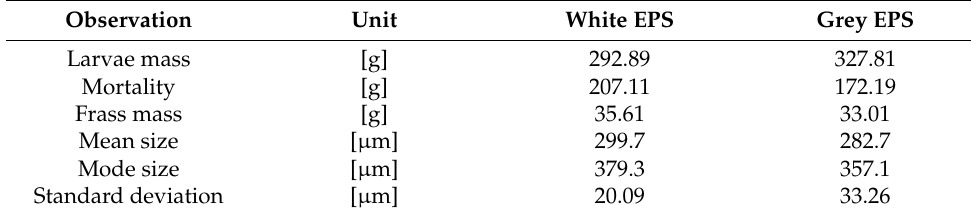
Table 2. Larvae population and frass characteristics.